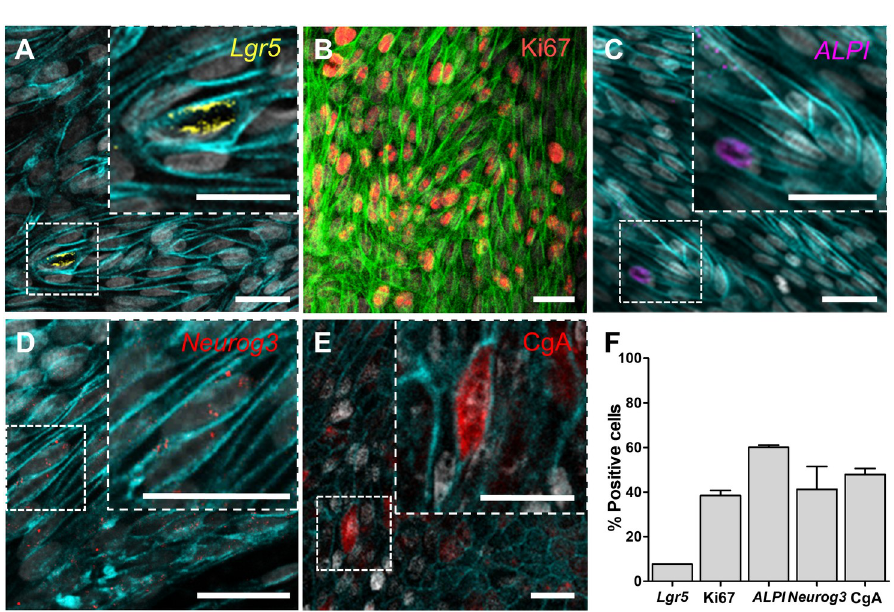
Fig 3. The cell type-specific characterization of the canine colonoid-derived epithelial monolayer. The canine colonoid-derived monolayer on Day 13 was used to visualize the markers highlighting the cell lineages, proliferation, and mucus production. The population of stem cells (A; Lgr5 +, Yellow), proliferative cells (B; Ki67, Red), absorptive enterocytes (C; ALPI , Magenta), and enteroendocrine cells (D; Neurog3 , Red and E; CgA, Red) were visualized by using RNA in situ hybridization (for A, C, and D) or IF staining (for B and E). As a counterstaining, E-cadherin (Cyan for A, C, and D), F-actin (Green for B and Cyan for E), or nuclei (Grey for A, B, C, D, and E) were displayed. Bars, 20 μ m. (F) Quantification of the population of the cells that show positive signals to the target markers normalized by the total numbers of nuclei. Three independent fields of view from two or more independent biological replicates were used. In each biological replicate, 2 technical replicates were performed. Error bars indicate